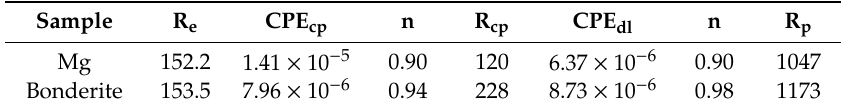
Table 6. Fitted parameters of the EIS data for the Mg and Bonderite specimens after 24 h of immersion in 0.5 % wt. NaCl. (R given in Ω cm 2 ; CPE given in S s − n cm − 2 ).